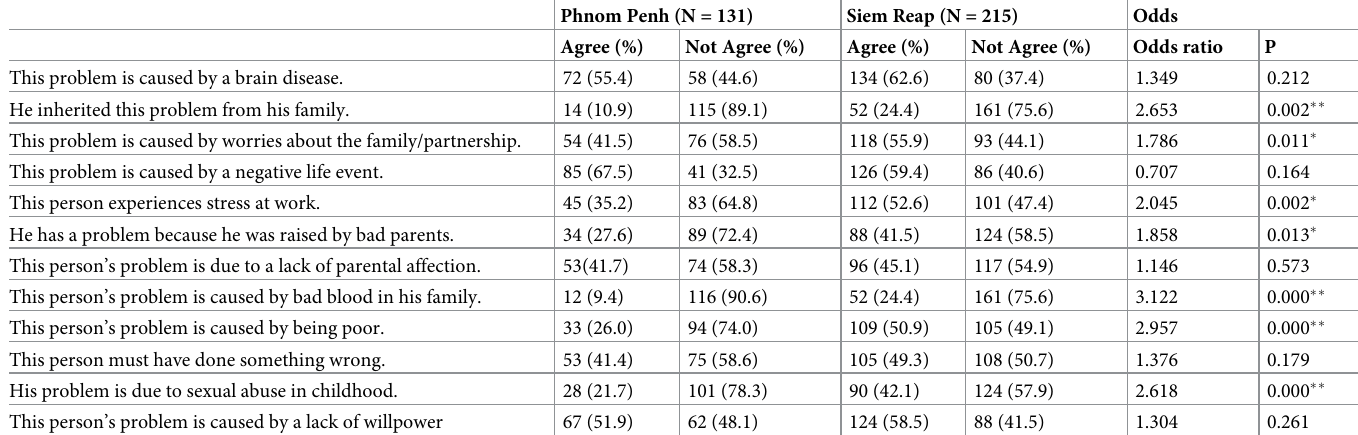
Table 2. Participants’ causal attributions for